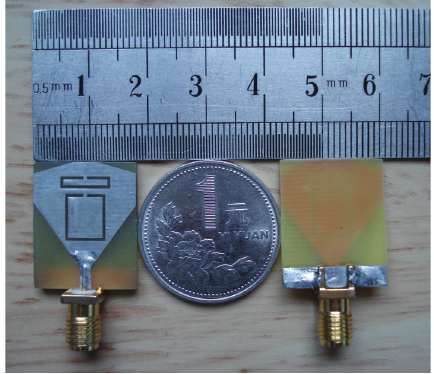
Figure 4: Photograph of the proposed dual band-notched antenna.